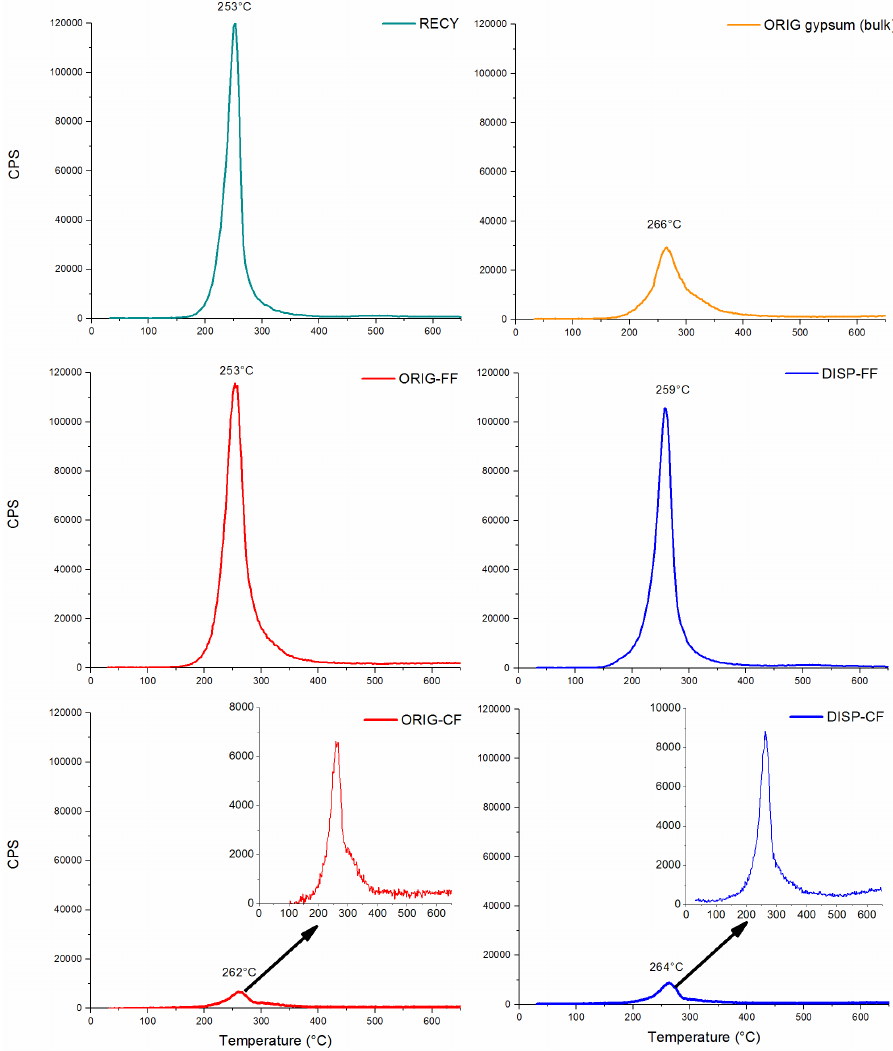
Figure 4: TPD spectra of five separated WFGD samples (fine and coarse fractions) and one mixed fraction containing both fractions (bulk gypsum).